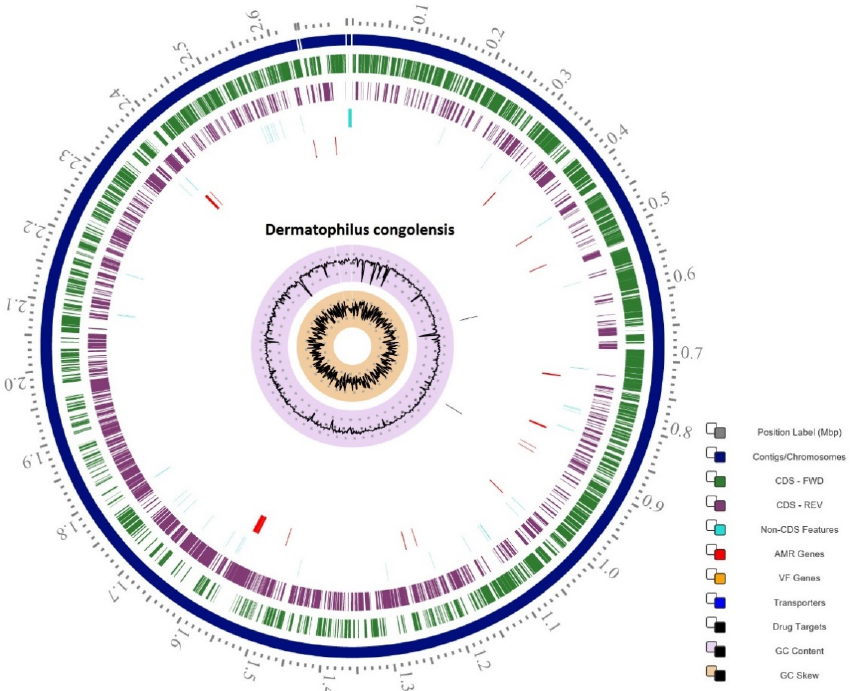
Figure 6. Circular view of a representative D. congolensis genome showing all features including antimicrobial resistance genes (red) and drug targets (black).